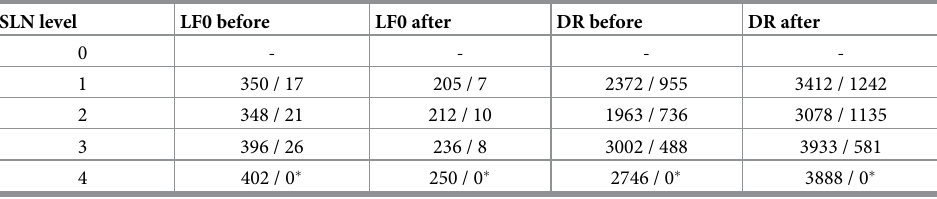
Table 4. Median values for (up to) 10 cycles before and after a mode change were calculated for LF0 and DR. In this table the mean values and standard deviations for these values based on SLN level are given.